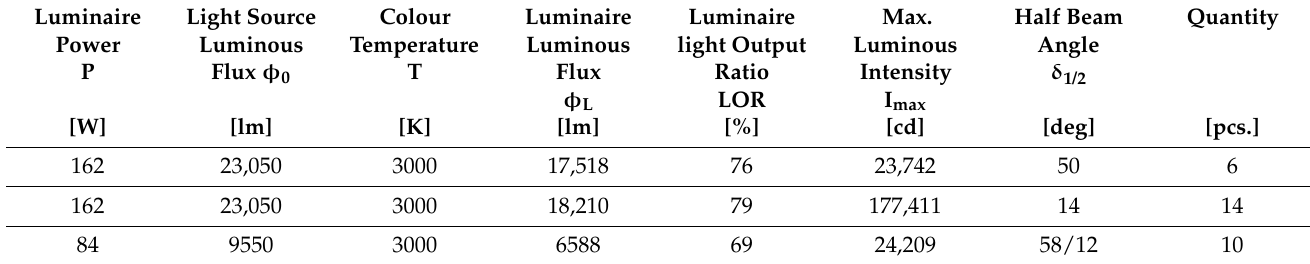
Table 1. The specification for the lighting equipment applied under the floodlighting design for the Basilica of the Dormition of the Blessed Virgin Mary in